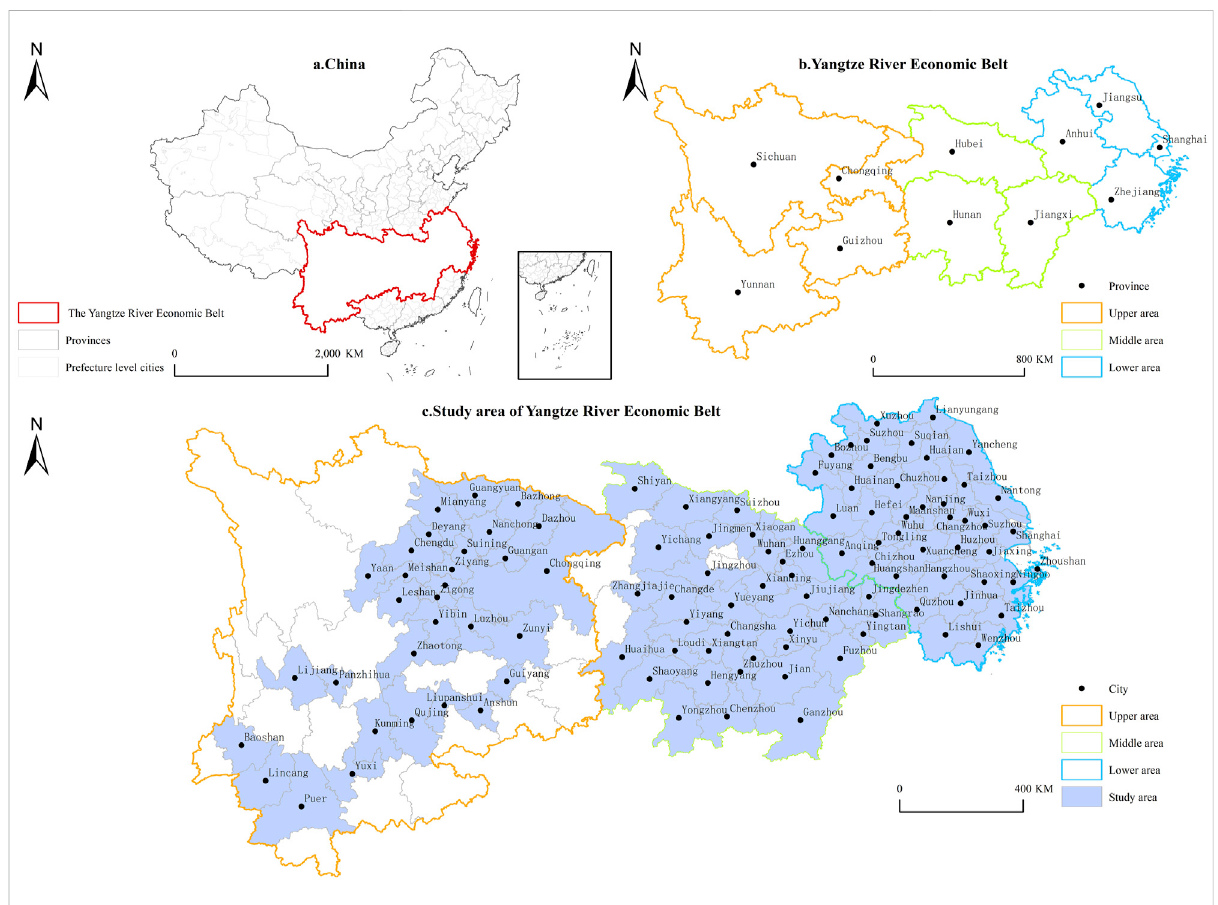
FIGURE 2 The geographical location of study